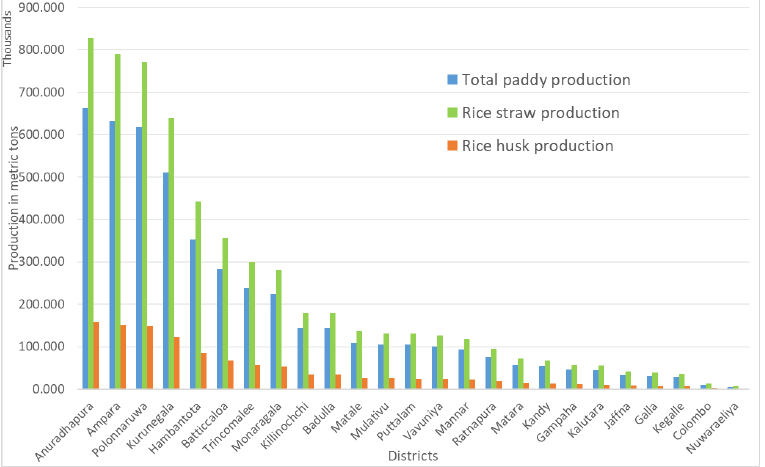
Figure 5. Total production of paddy, rice straw, and rice husk in the year 2019/2020 (Source: Sri Lanka Rice Research Center).